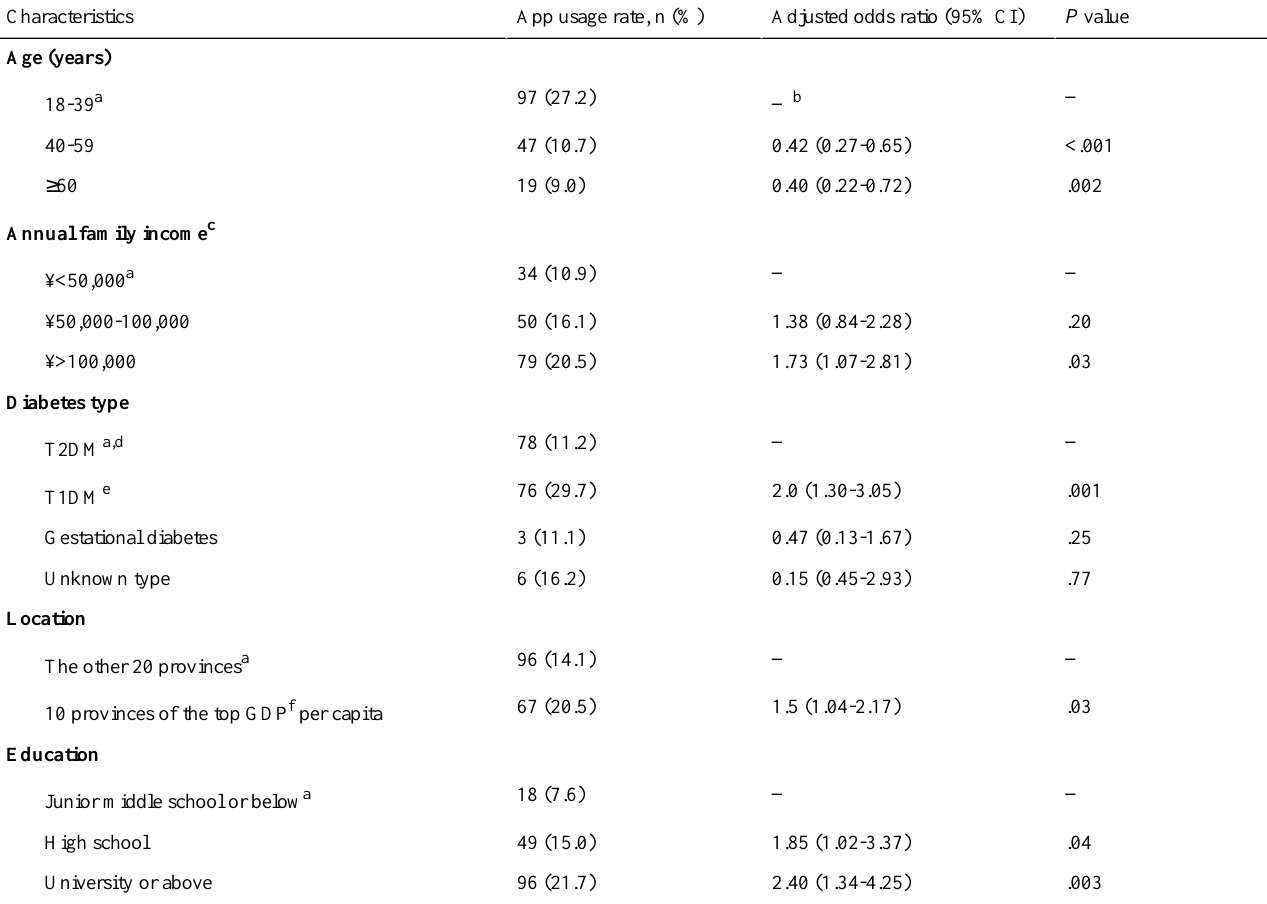
Table 2. Factors associated with app use by multivariate logistic regression analysis